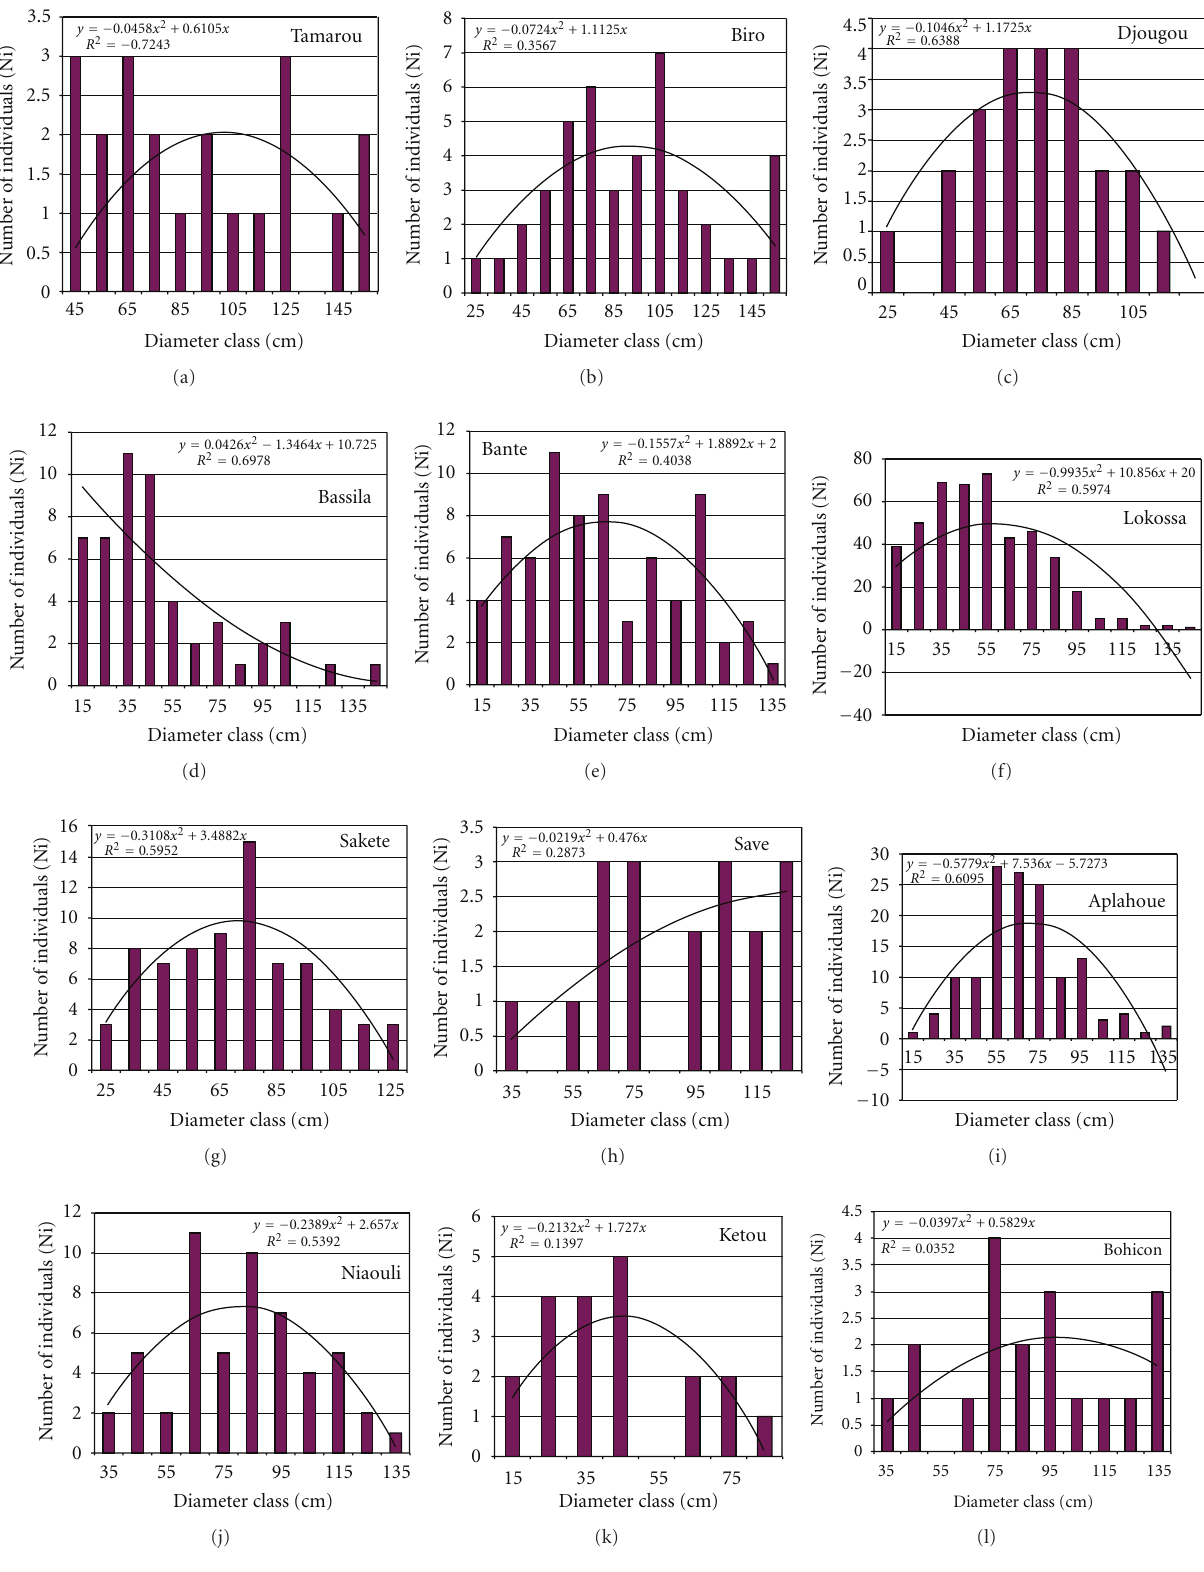
Figure 5: Diameter distribution of Milicia excelsa